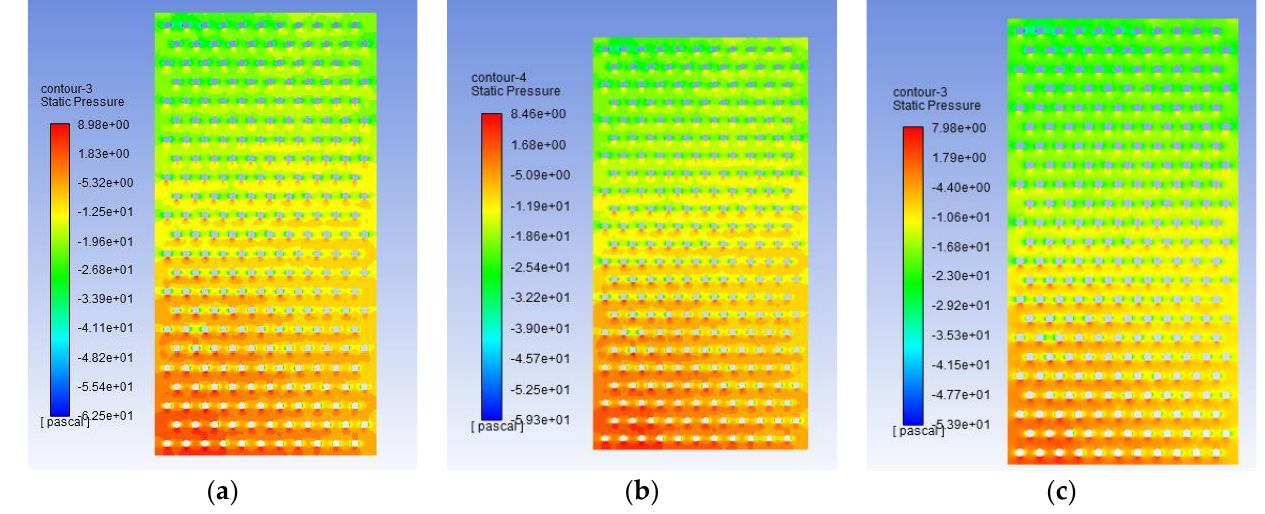
Figure 7. The pressure distributions corresponding to different relative humidities of inlet ambient air. ( a ) Pressure nephogram for RH 0 = 80%. ( b ) Pressure nephogram for RH 0 = 85%. ( c ) Pressure nephogram for RH 0 = 90%.